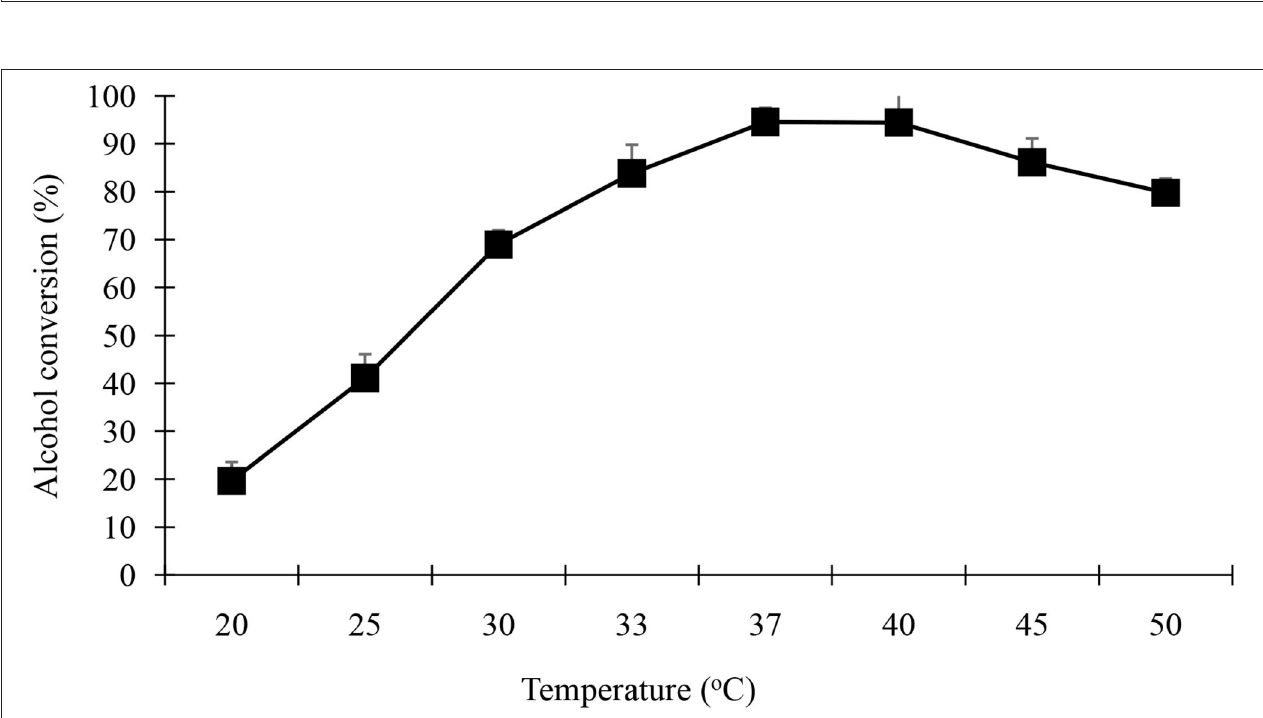
FIGURE 8 | Effect of different temperature on the synthesis of geranyl butyrate ester. The reaction mixture consist of 0.25M of each of butyric acid and geraniol at 37 o C in the presence of 0.25g of acetone powder from day 4 of germinated black cumin seedling in 5mL of hexane.